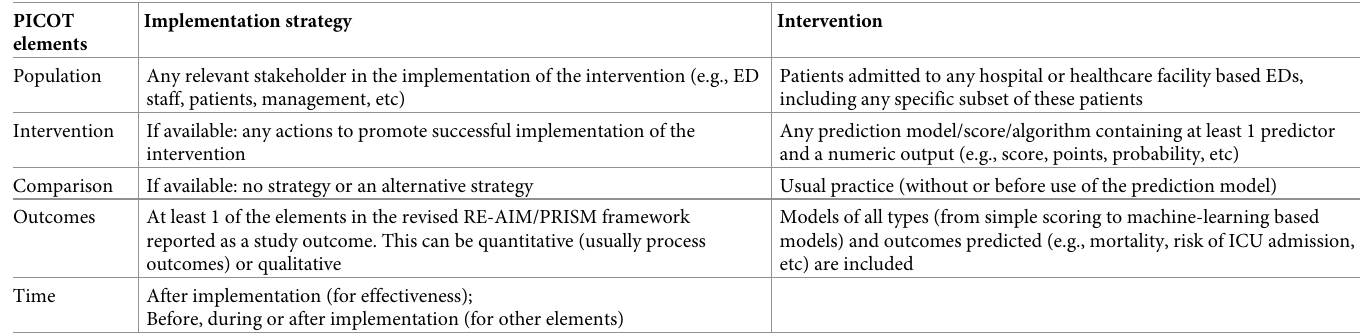
Table 1. Inclusion and exclusion